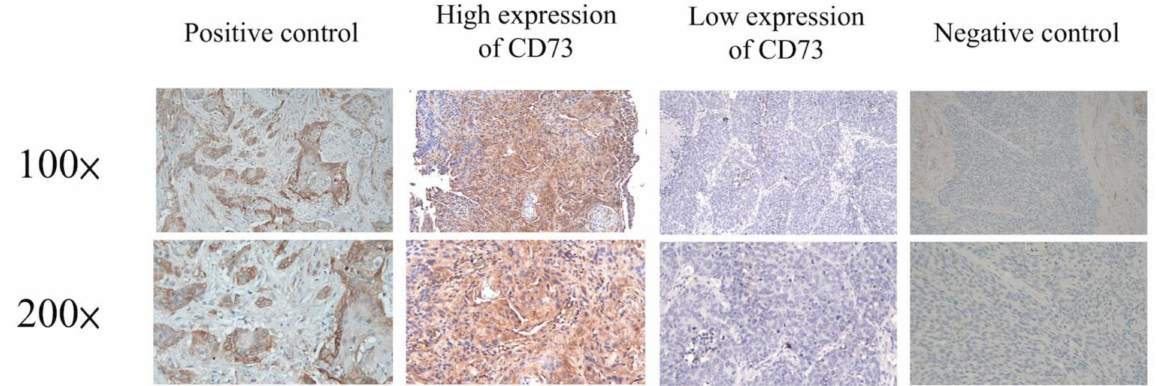
Figure 1. Results of the immunohistochemical analysis of cluster of differentiation (CD)-73 in patients with esophageal squamous cell carcinoma